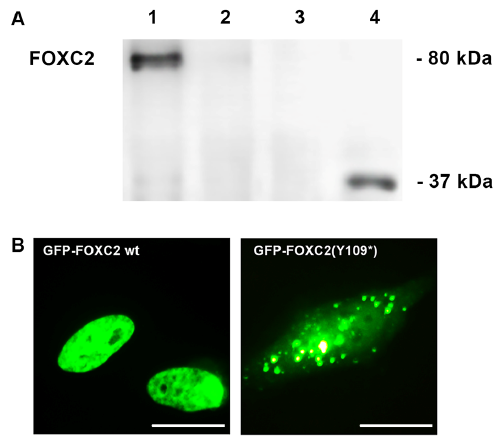
Figure 3. Exogenous expression of p(Y109*) FOXC2 mutant protein. ( A ) Western blot analysis of